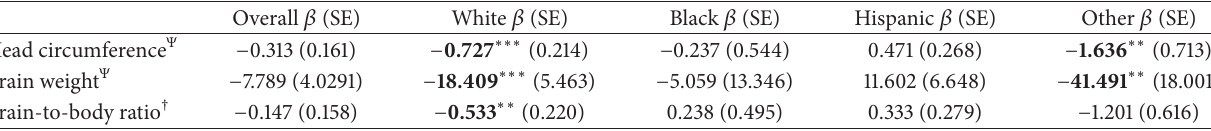
Table 3: Multiple regression results for the association between maternal TPO status and fetal/infant brain growth variables by race/ethnicity.